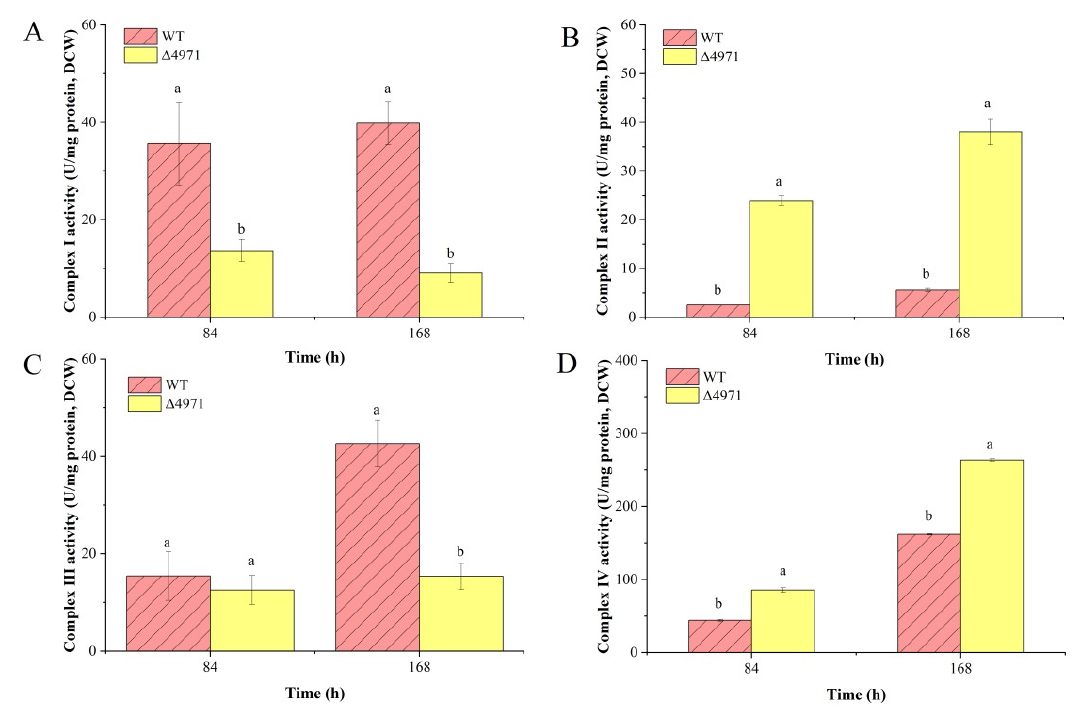
Figure 7. Comparison of the activities of enzyme complex I ( A ), complex II ( B ), complex III ( C ) and complex IV ( D ) of the parent strain and mutant strain during submerged batch-fermentation. Different letters (a and b) in the same column indicate a significant difference ( p < 0.05).